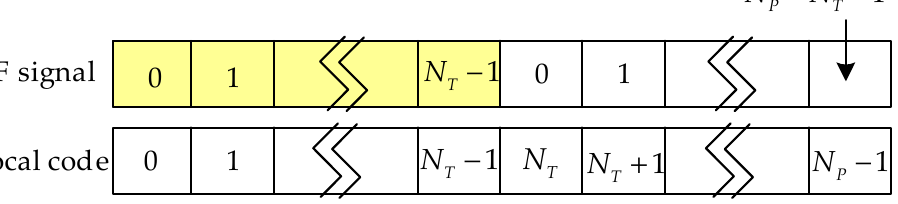
Figure 4. The TPRN leads to the nature of the correlation attenuation.